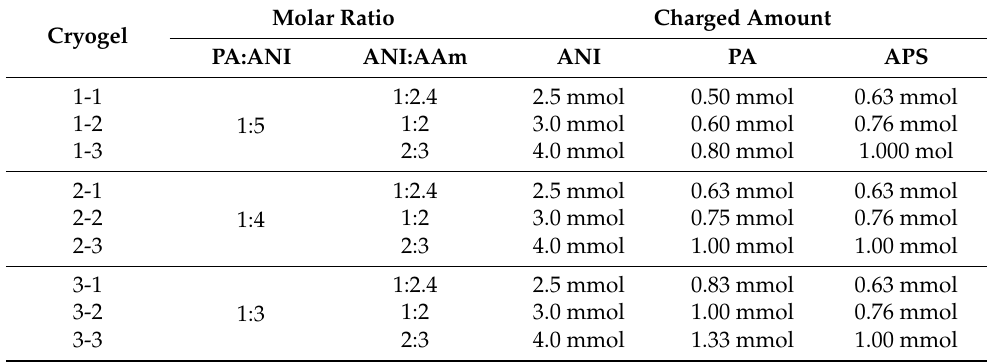
amount of water was 2.0 mL.